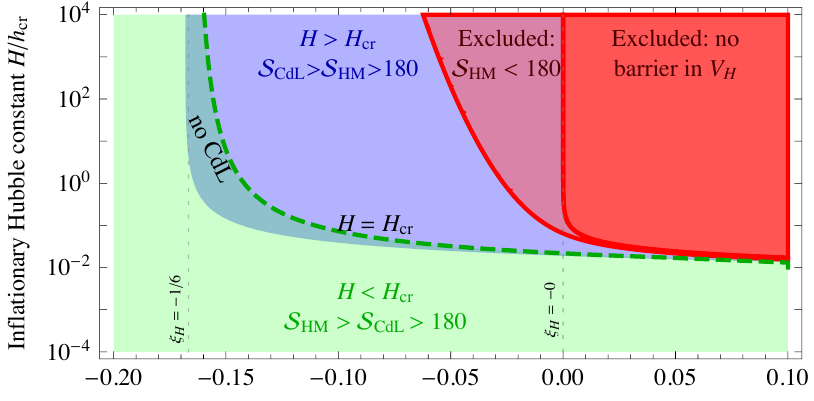
Figure 5 . As a function of (cid:24) H and of the Hubble constant in units of the instability scale h cr (and for N = 60 e -folds of in(cid:13)ation), we plot: the allowed region where H < H cr in green with dashed boundary; the region where tunnelling is dominated by Hawking-Moss in blue; in red the excluded region where tunnelling is too fast. For (cid:24) H < 0 this regions agrees with [18], while for (cid:24) H > 0 our bounds are